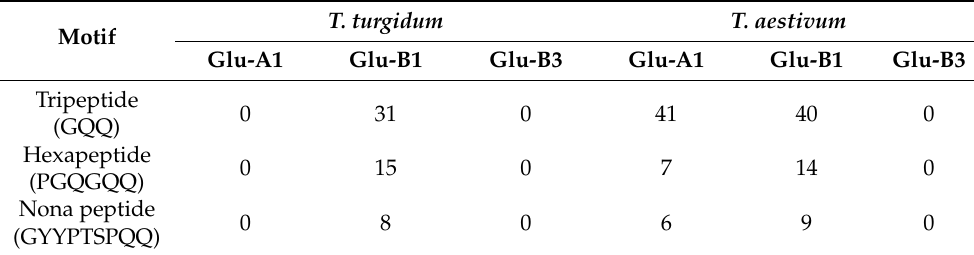
Table 6. Repeat motifs of Glu-A1, Glu-B1, and Glu-B3of T. turgidum and T. aestivum.